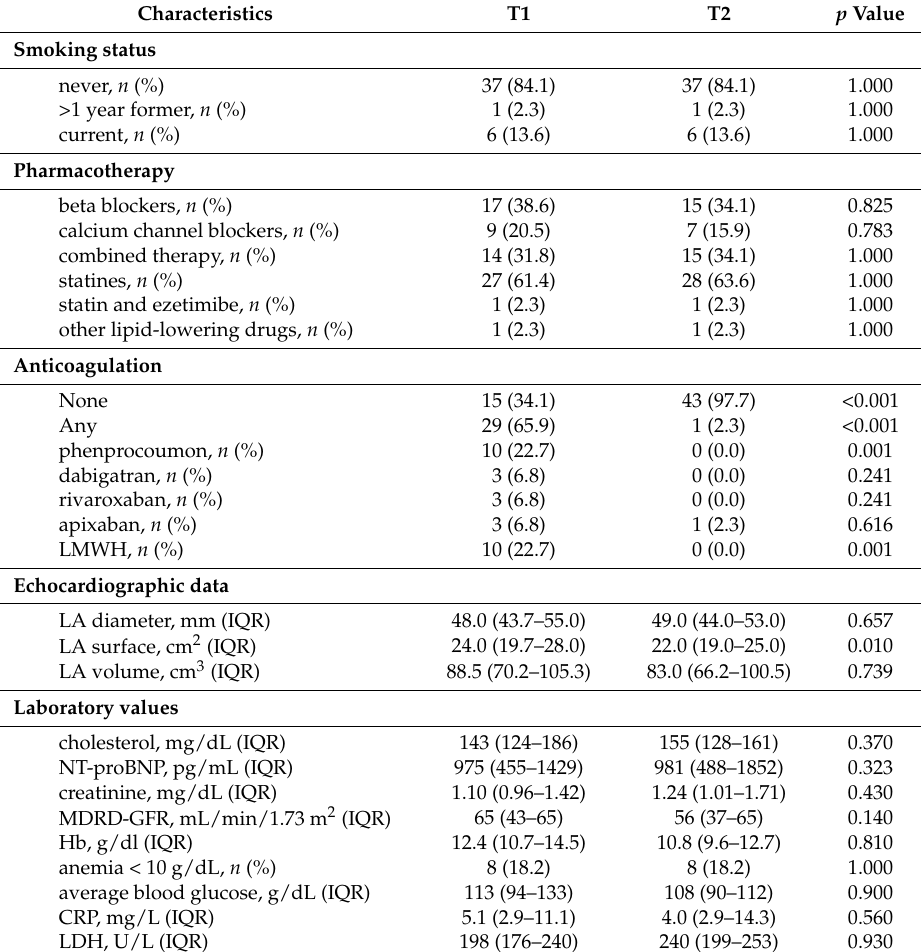
Table 2. Changes of patients’ characteristics over mid-term follow-up.